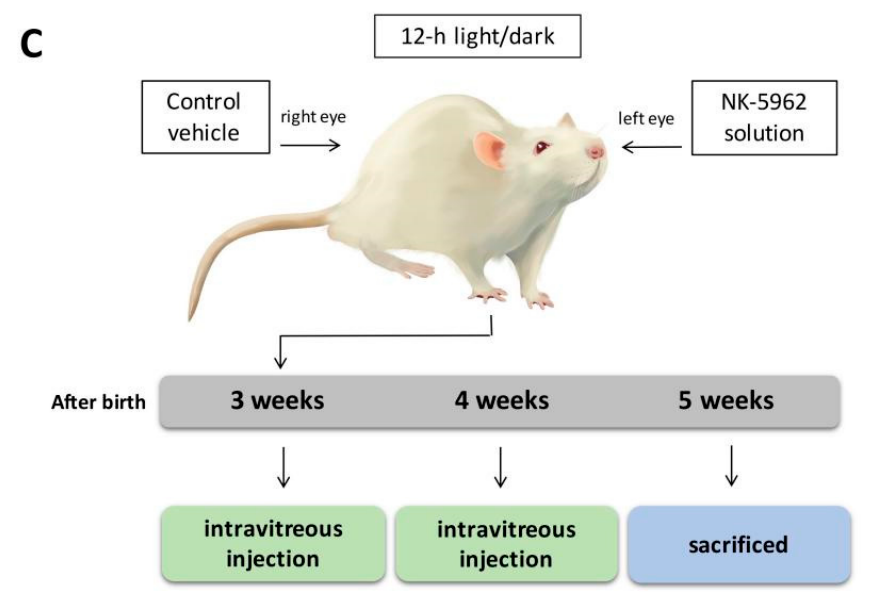
Figure 1. NK-5962 and experimental design. ( A ) Chemical structure of NK-5962. ( B ) NK-5962 solution (8.2 µ g/mL). ( C ) Experimental schedule.